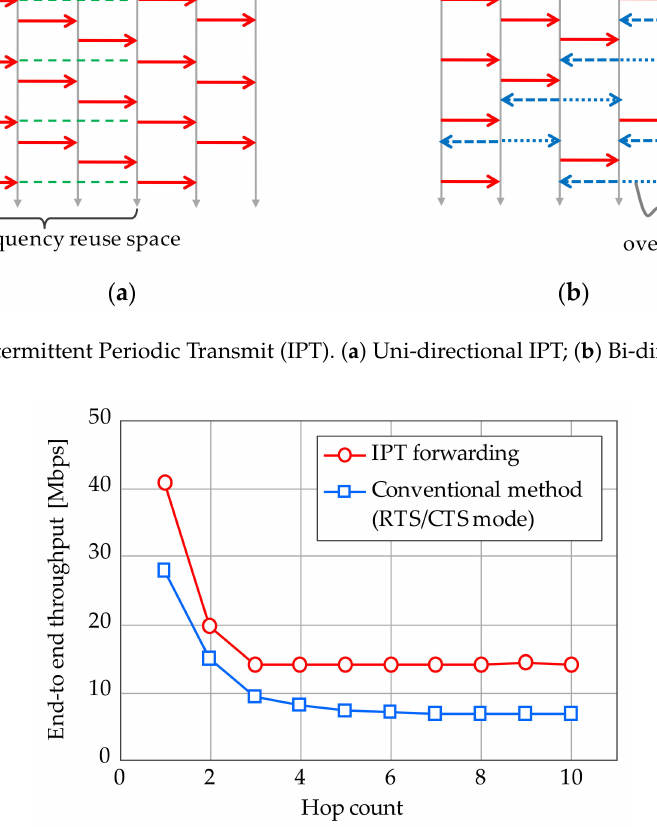
Figure 3. Basic throughput performance of IPT on string